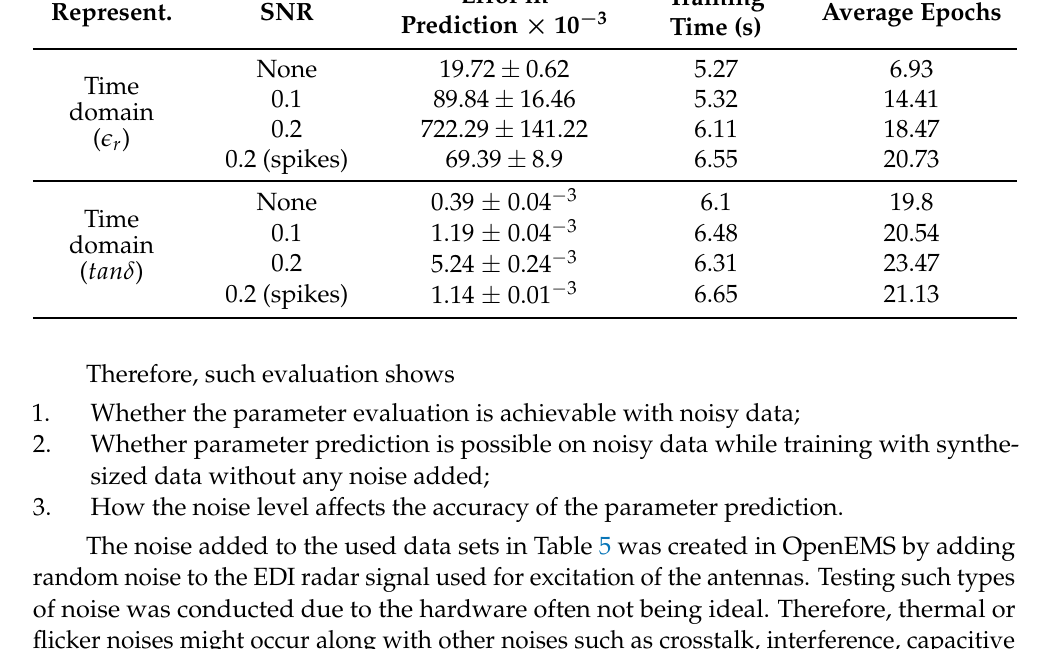
Error in Prediction × 10 −